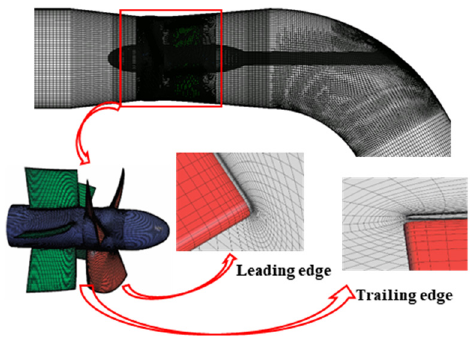
Figure 3. Meshing of Pump Sections.